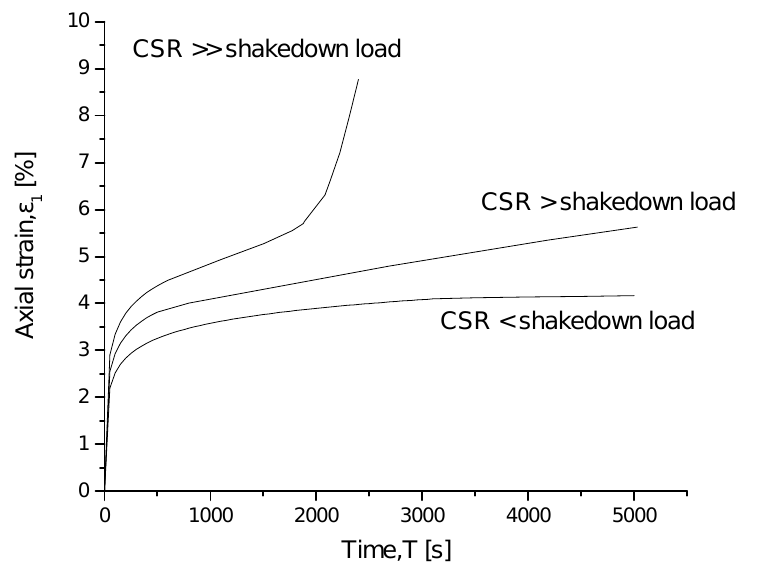
Figure 1. Influence of CSR on clay cyclic stress–strain behaviour